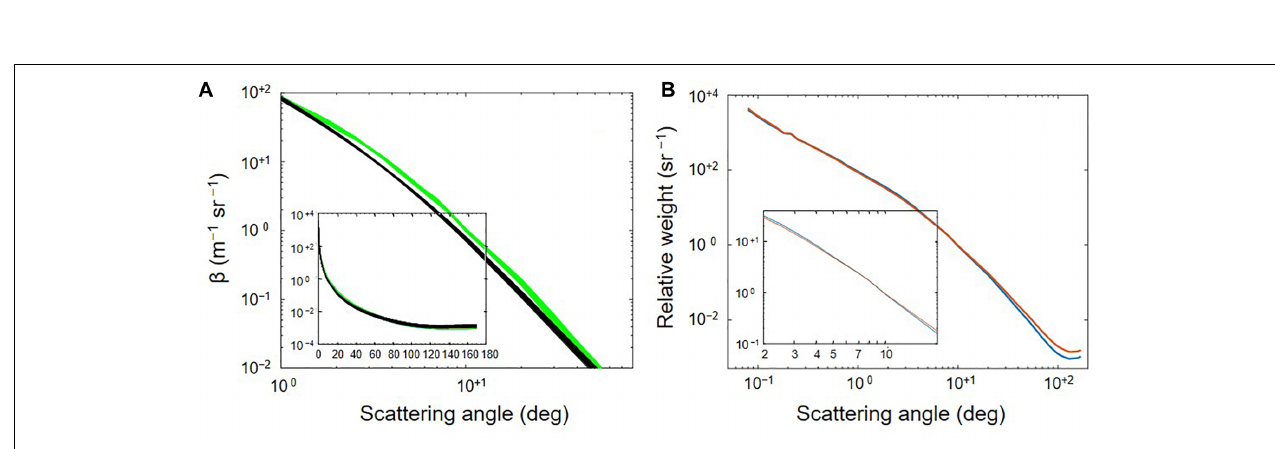
FIGURE 2 | (A) Fifteen, 1-m binned VSFs (green) from a single profile collected in the New York bight 11/2007, highlighting the ∼ 1 ◦ to 70 ◦ range where Fournier-Forand phase function fits (black) systematically underestimate. Inset shows semi-log scale over full range. RMS error for the profile was 17.5%. (B) Two fitting clusters for data collected in the New York bight, derived using the method of Moore et al. (2009, 2014, see text). The vertical axis (i.e., relative weight) corresponds to β normalized by its integrated value over available scattering angles. One cluster exhibits about twice the amount of scattering in the backward direction relative to the other. There is also a cross-over point at 7 ◦ (see inset). Fitting the same profile data from panel (B) with the 2 clusters model results in an improved RMSE of